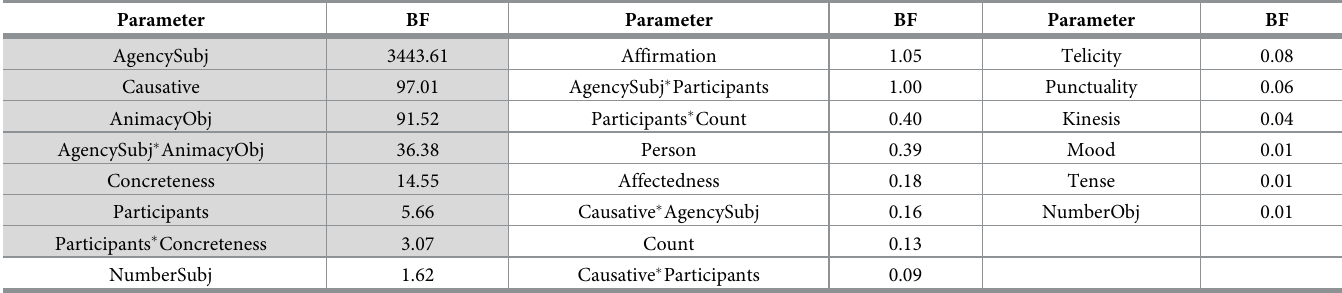
Table 6. Bayes factor results indicating the posterior log odds against the null hypothesis of no effect of each